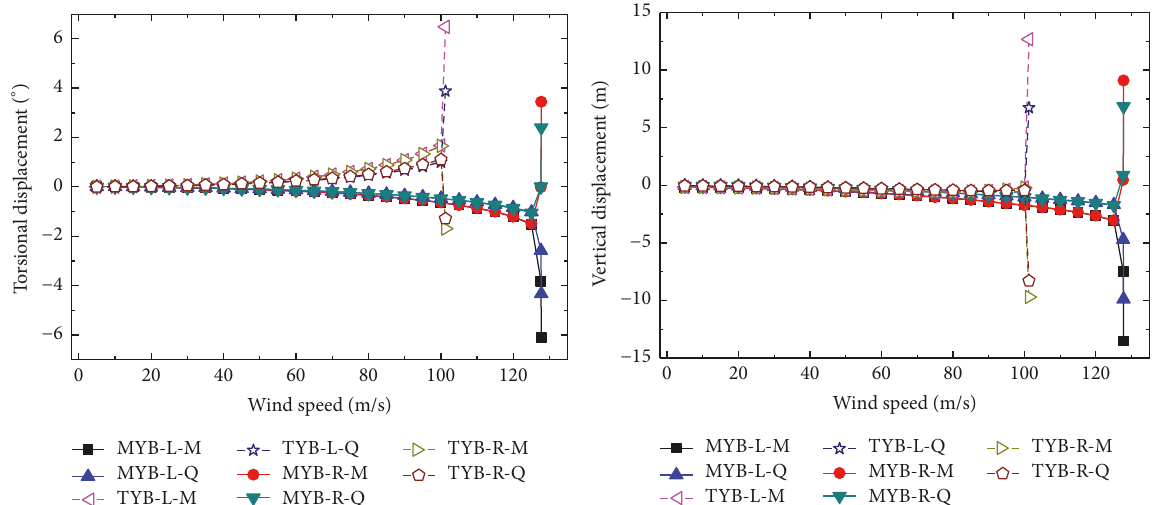
Figure 7: The torsional and vertical displacements for MYB and TYB with an initial attack angle of 0 ∘ . L: left; R: right; M: midspan point; Q: quarter-span